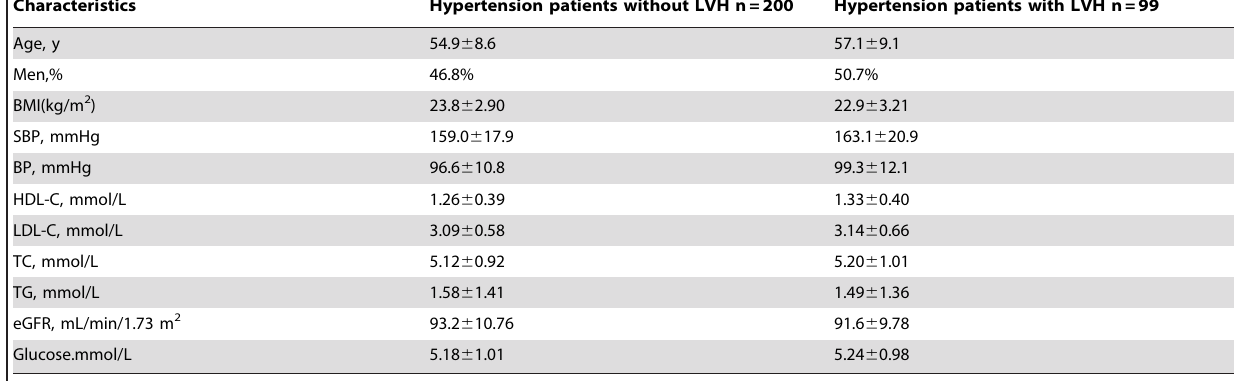
Table 1. Clinical Characteristics.